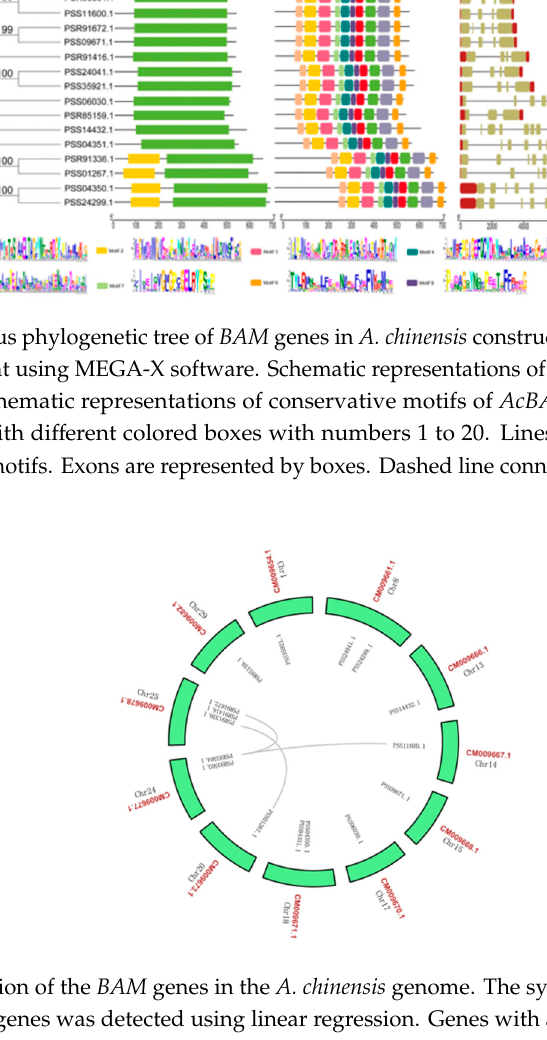
Figure 6. Phylogenetic trees of BAM genes in A. chinensis , Camellia sinensis , Citrus trifoliata , Vaccinium corymbosum , Pyrus bretschneideri, and A. thaliana based on maximum likelihood analysis of the BAM domain amino acid sequence alignment. The five AcBAMs from clades A include PSS11600.1, PSR93503.1, PSR93504.1, PSS09671.1, an PSR91672.1. In addition, they share more than 90% sequence similarity (Figure 7). According to 5 AcBAM genes sequences, we designed primers to clone the full-length AaBAM gene in A. arguta . Due to the genomic differences between the Actinidia arguta and Actinidia chinensis , we obtained only one BAM gene by homologous cloning. Additionally, this one BAM gene was named AaBAM3, and it had a full-length of 1644 bp (Genebank Accession Num. 2327905) .